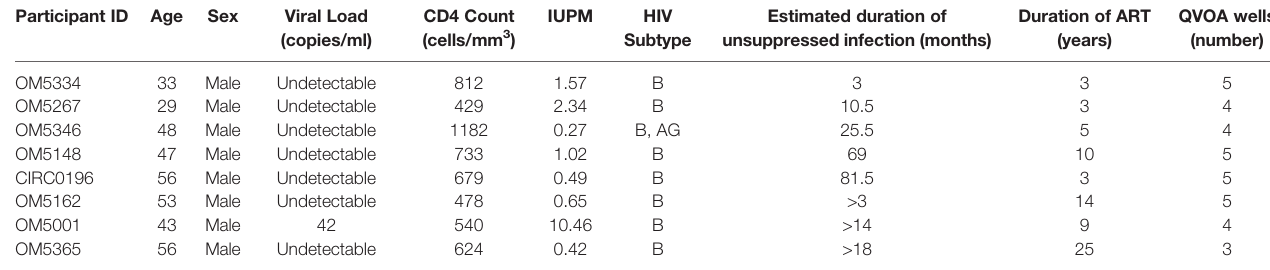
TABLE 1 | Clinical characteristics of study